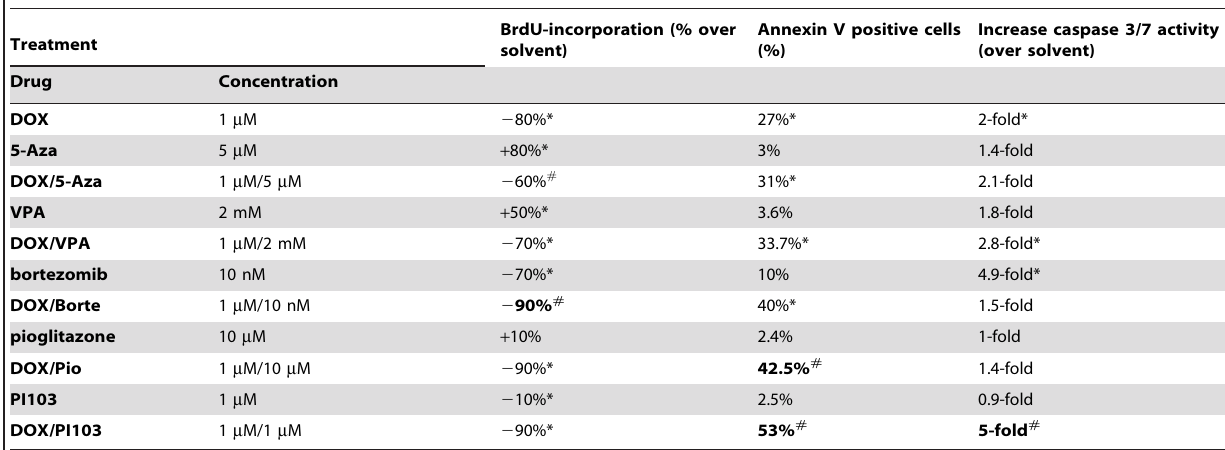
Table 1. PI103 sensitizes HT1080 cells to DOX-induced apoptosis.